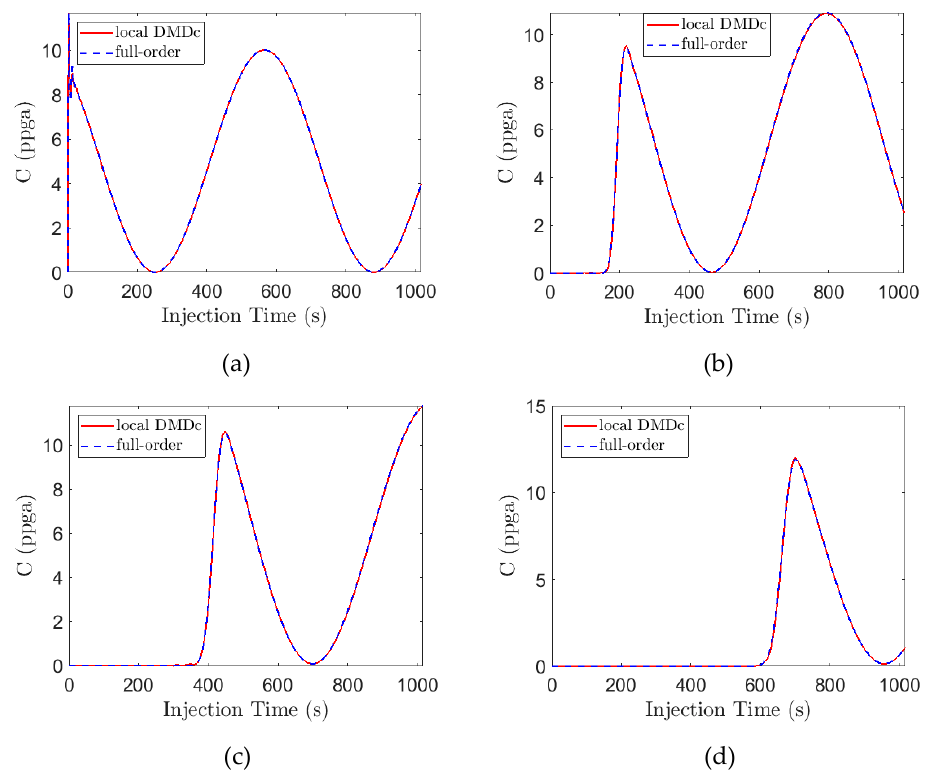
Figure 13. Results comparing local DMDc and full-order solutions of concentration at 4 different locations inside the fracture. ( a ) 𝐶(𝑡) at x = 18 m; ( b ) 𝐶(𝑡) at x = 36 m; ( c ) 𝐶(𝑡) at x = 72 m; ( d ) 𝐶(𝑡) at x = 108 m.